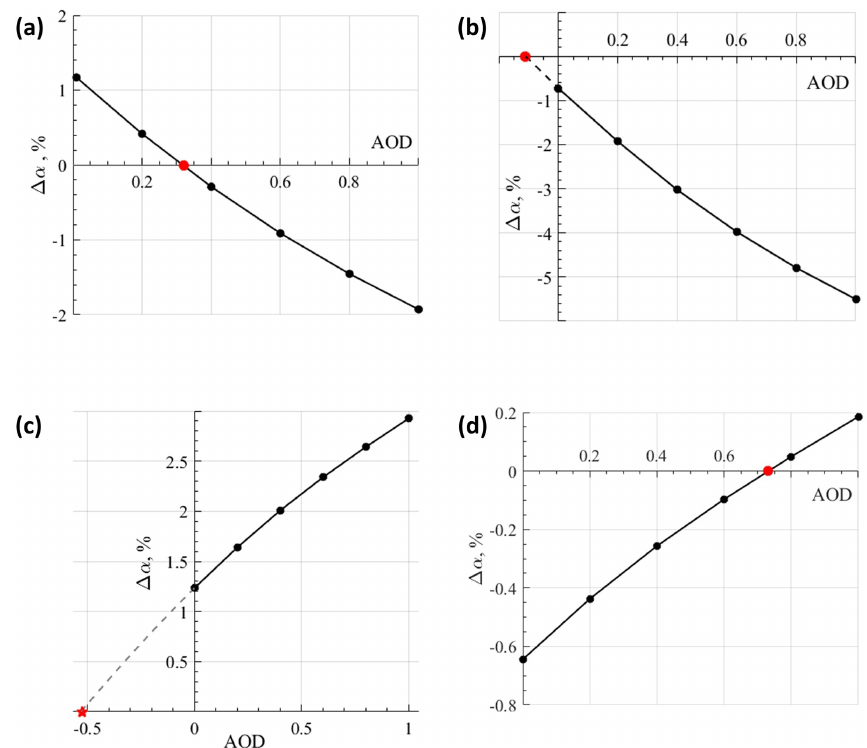
Figure 1. RT simulations (black dots) shows deriving τ c (red dot) for different cases of aerosols and surfaces. For pristine conditions (AOD = 0), diurnally-averaged (cid:49)α is negative for bright surfaces and positive for dark surfaces. An increase in aerosol loading by absorbing (scattering) type of aerosol leads to decrease (increase) in TOA albedo. (a) Absorbing aerosols above a dark surface, (b) absorbing aerosols above a bright surface, (c) scattering aerosols above a dark surface and (d) scattering aerosols above a bright surface.